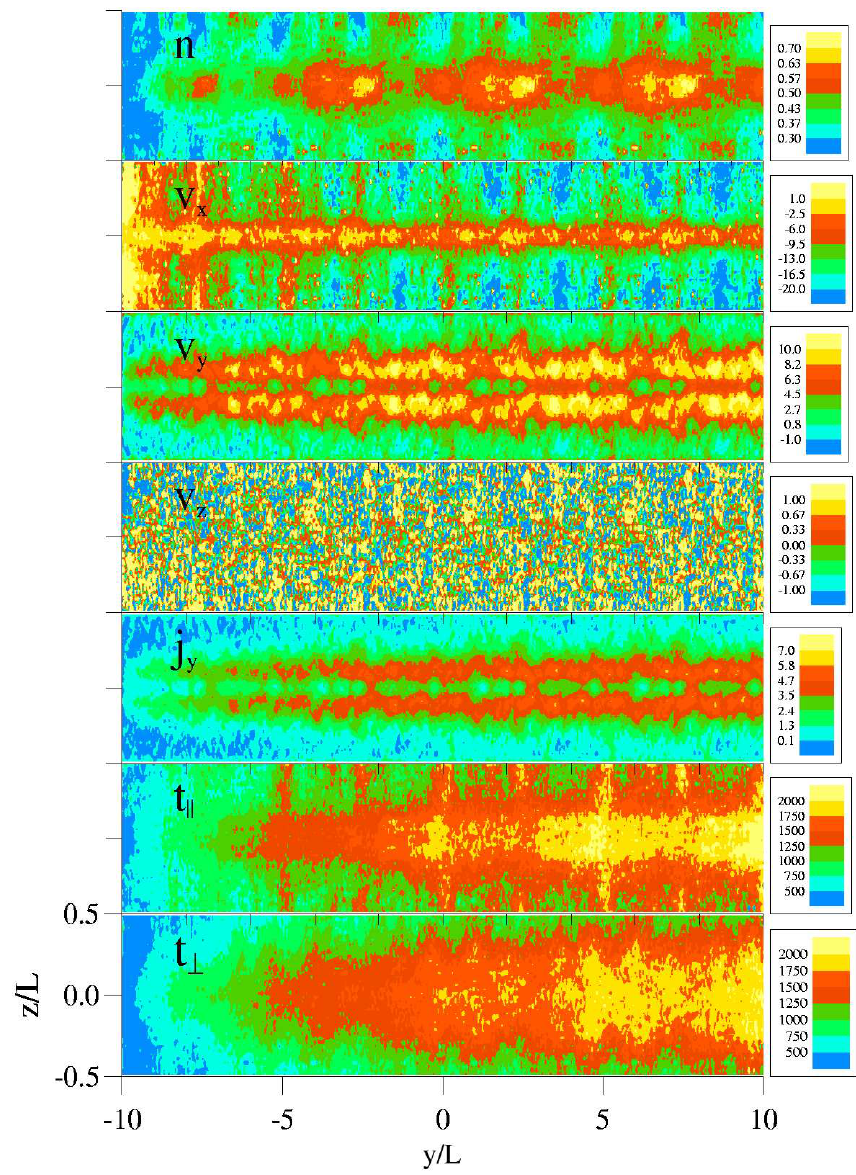
Fig. 2. Same as Fig. 1 but for δb = 0 . 5 and b n = 0 .